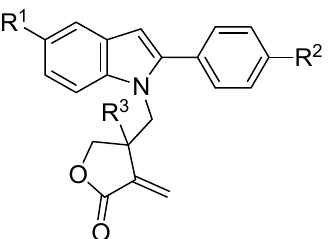
Figure 34. Indole α -methylene- γ -lactones.